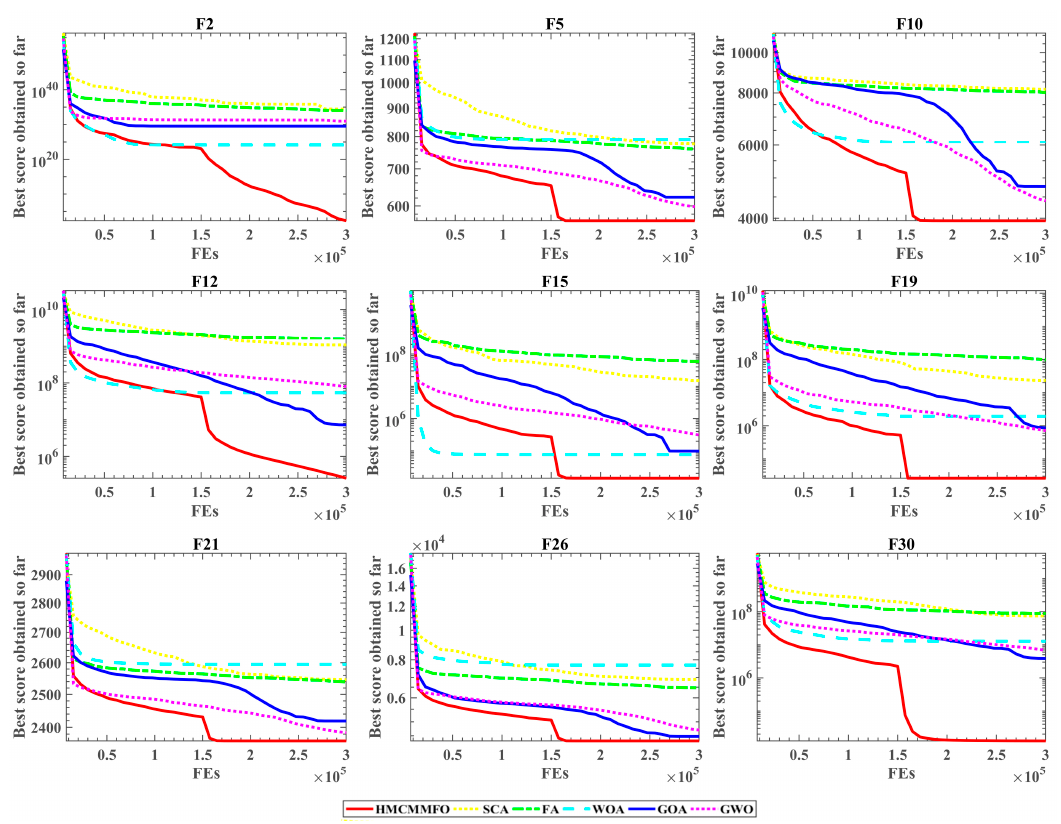
Figure 5. Convergence effect of original algorithms.